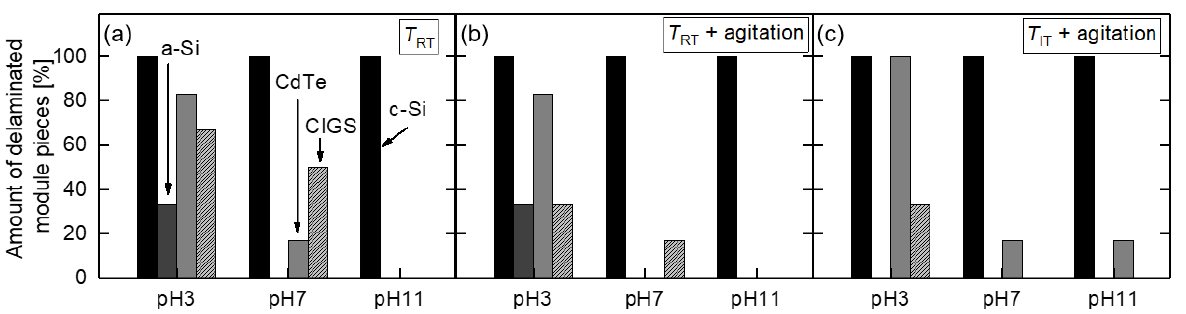
Figure 1. Amount of delaminated module pieces from crystalline silicon (c-Si), amorphous silicon (a-Si), cadmium telluride (CdTe), and copper indium gallium diselenide (CIGS) depending on the pH value of the water-based solution after 1.5 years for the three different experimental conditions: ( a ) T RT = 25 ◦ C, no agitation, ( b ) T RT = 25 ◦ C, with agitation, and ( c ) T IT = 40 ◦ C, with